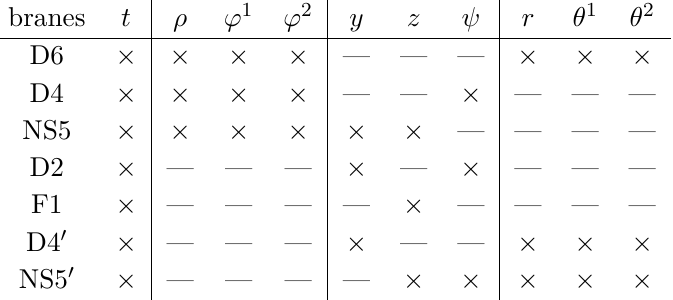
Table 5 . BPS/8 intersection describing F1-D2-D4 0 -NS5 0 branes ending on a D4-NS5-D6 bound